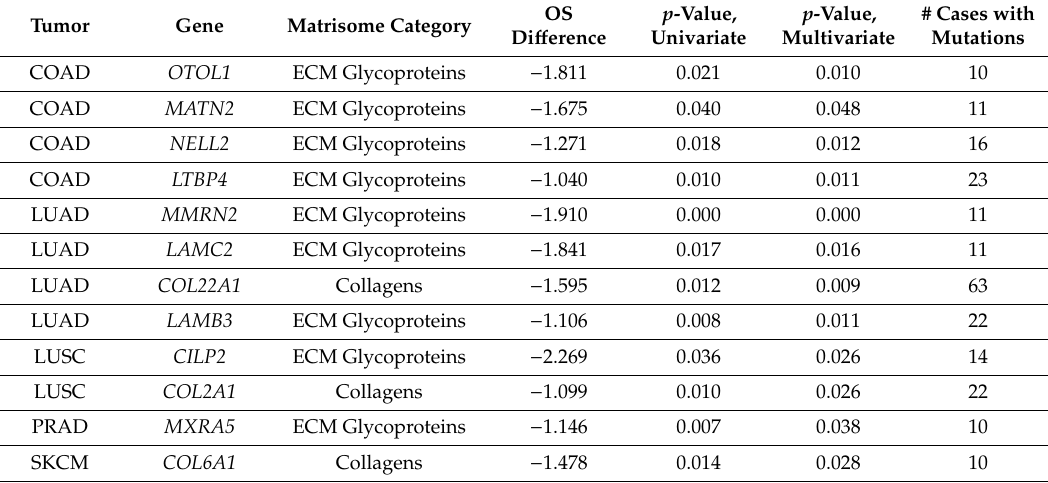
Table 3. Mutated core matrisome genes impacting patient